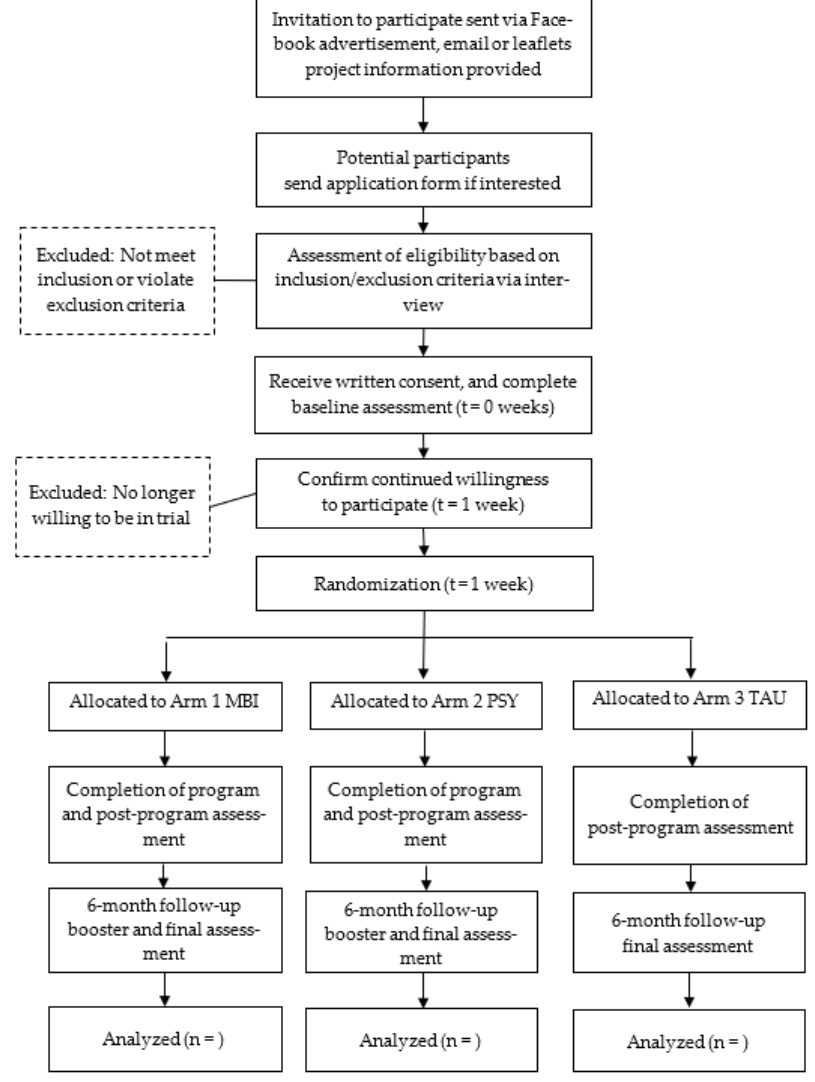
Figure 1. Recruitment flowchart.